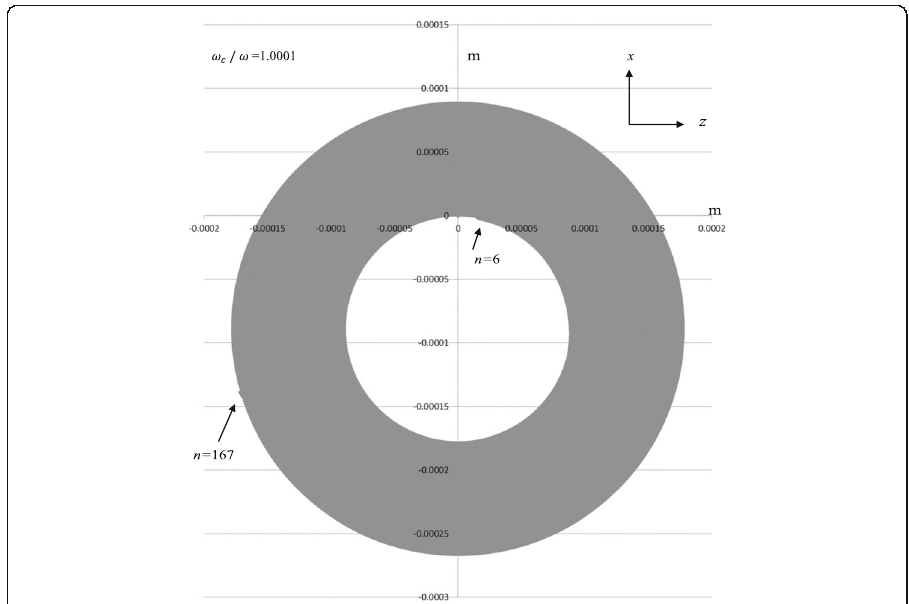
Fig. 9 The gyration orbit of a relativistic electron in the x - z plane, based on Eqs. (20) and (21). The initial velocity ^ z z 0 ¼ − ^ z 0 : 31 (cid:2) 10 8 m/s at ( t = 0), E ( t ) = − ^ z 400 cos ω t , B = 2.0 T, ω c ¼ j ^ y 3 : 5 (cid:2) 10 11 j sec − 1 and